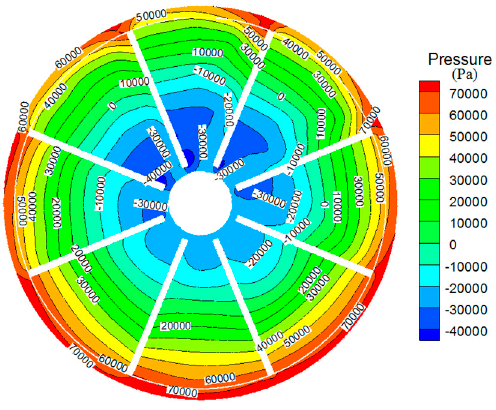
Figure 5. Static pressure distribution for the axial cross-section Z = − 10 mm.